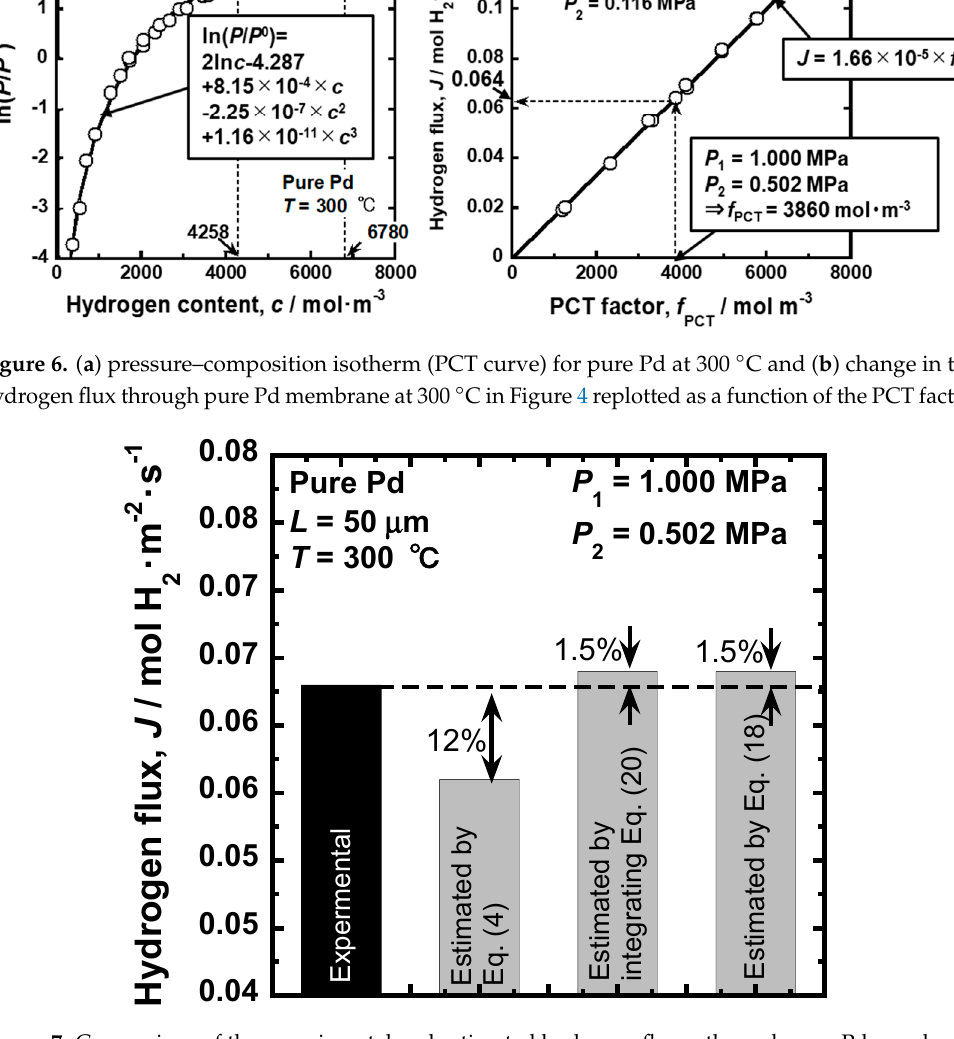
Figure 7. Comparison of the experimental and estimated hydrogen fluxes through pure Pd membrane at 300 °C under a pressure condition of 1.000 MPa at the feed side and 0.502 MPa at the permeation side. The estimations were carried out using the conventional hydrogen permeation coefficient, the pressure-dependent hydrogen permeation coefficient, and the PCT factor.